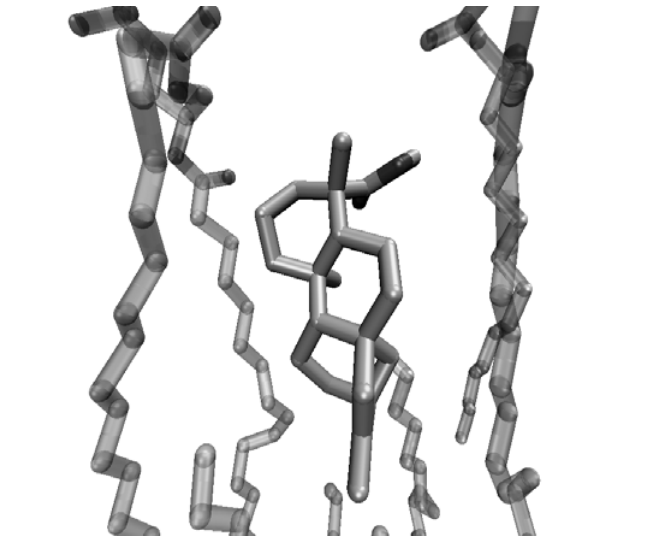
Figure 3 . Mode of insertion of one molecule of methyl kaurenoate ( 2 ) into a POPC